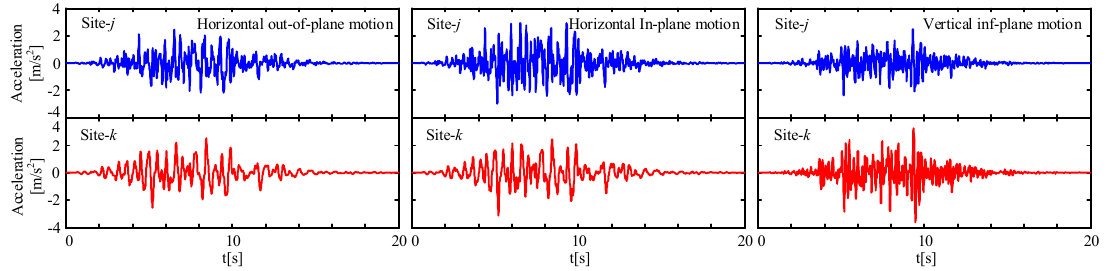
Figure 9. Simulated ground motions when Cs SI = 100 m/s, D SI = 5 m, and H SI = 5 m.